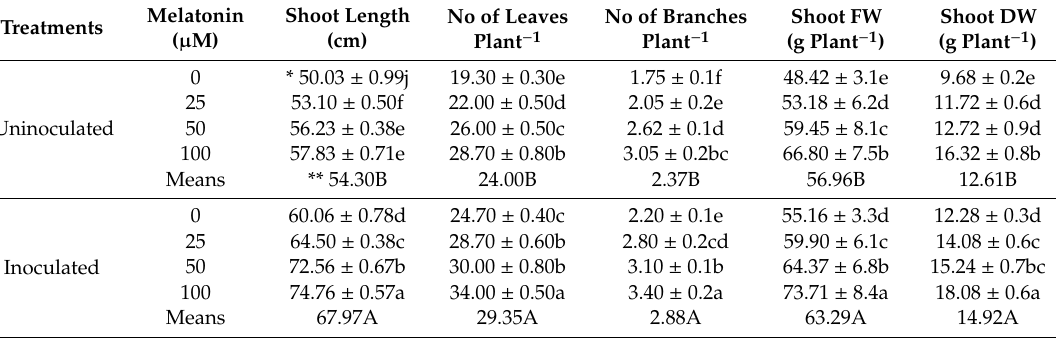
Table 3. E ff ect of EPS-producing bacteria and melatonin on growth parameters of faba bean grown in location two (non-saline